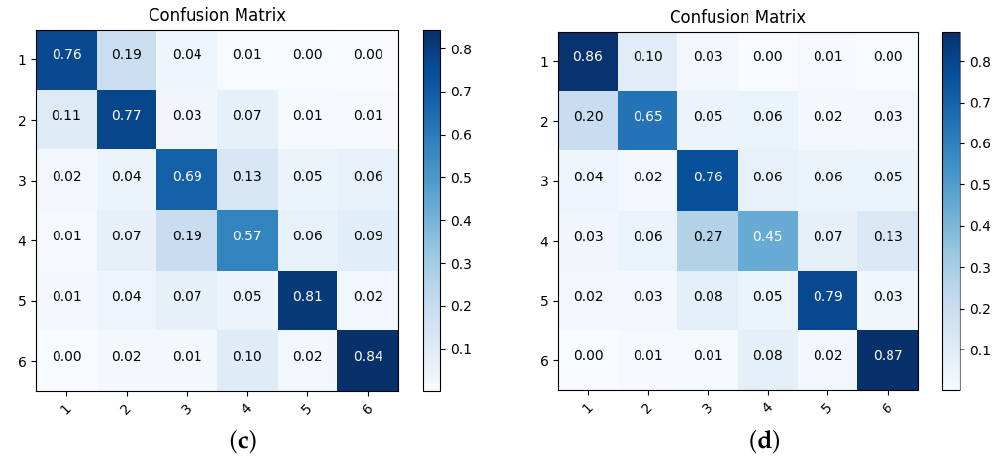
Figure A2. Confusion matrix computed over the test dataset for every method for 6 semantic LULC classes. ( a ) Confusion matrix for ConvLSTM-S1. ( b ) Confusion matrix for ConvLSTM-S2.